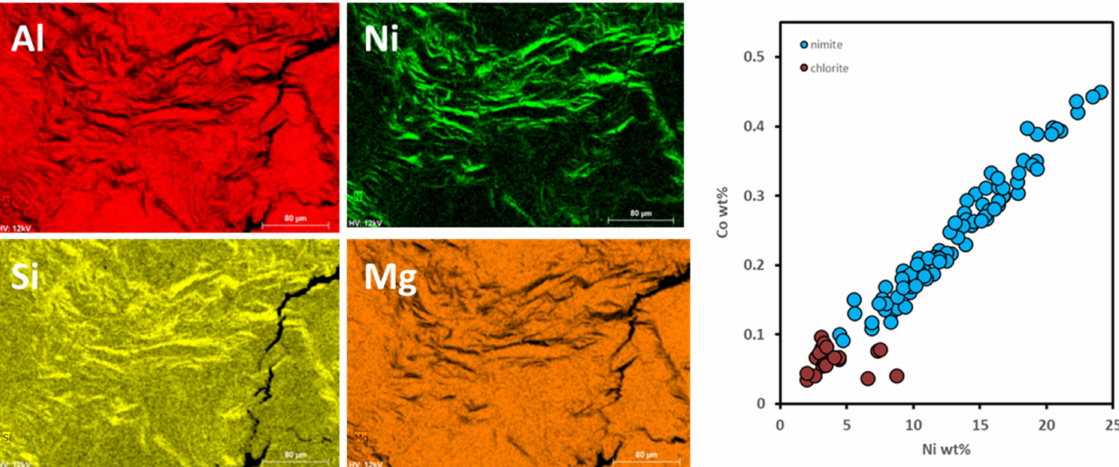
Figure 13. ( Left ) Al, Si, Ni and Mg element maps overlain the secondary electron (SE) image of Co enriched Ni silicate inclusions within the chlorite of SAPMG sample F002. ( Right ) Cobalt levels from EMPA analyses of the Co enriched Ni silicate inclusions. Blue filled circles = nimite, brown filled circles =